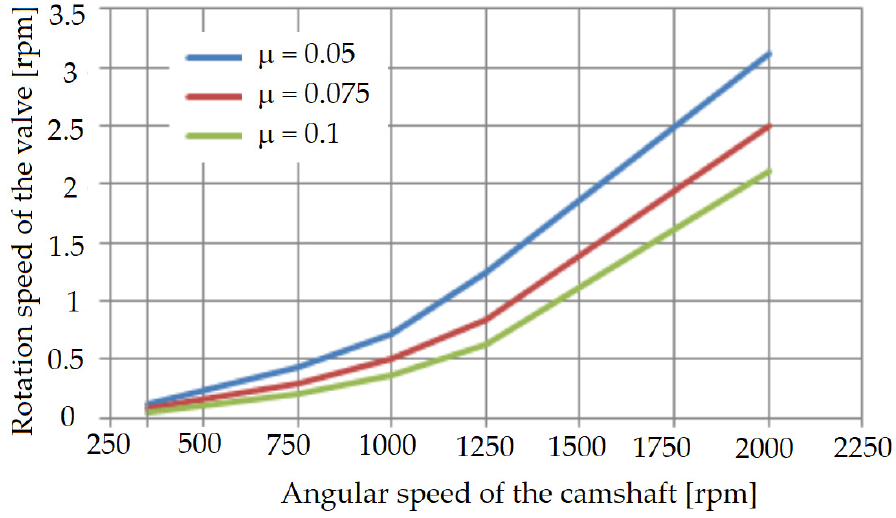
Figure 18. The influence of the coefficient of friction on the rotation speed of the valve.